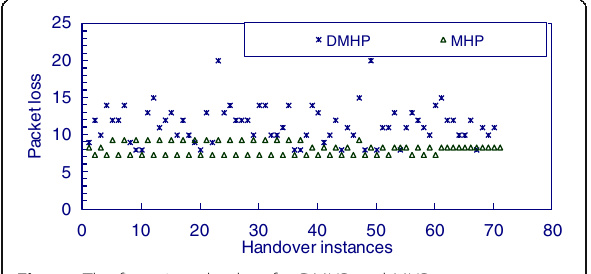
Fig. 14 The first 70 packet loss for DMHP and MHP